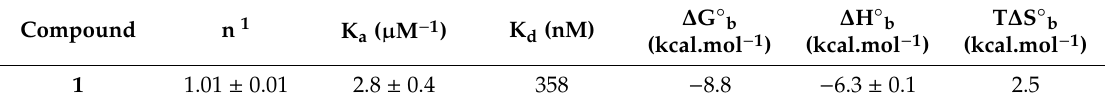
Table 5. Thermodynamic parameters of compound 1 binding to VIM-2 at 25 ◦ C. Compound